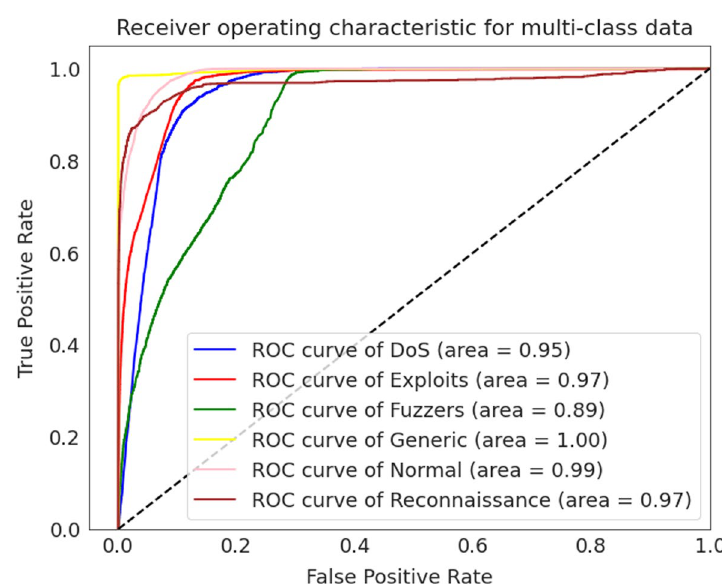
Fig. 12 ROC (receiver operating characteristic) curve of multi‑classification